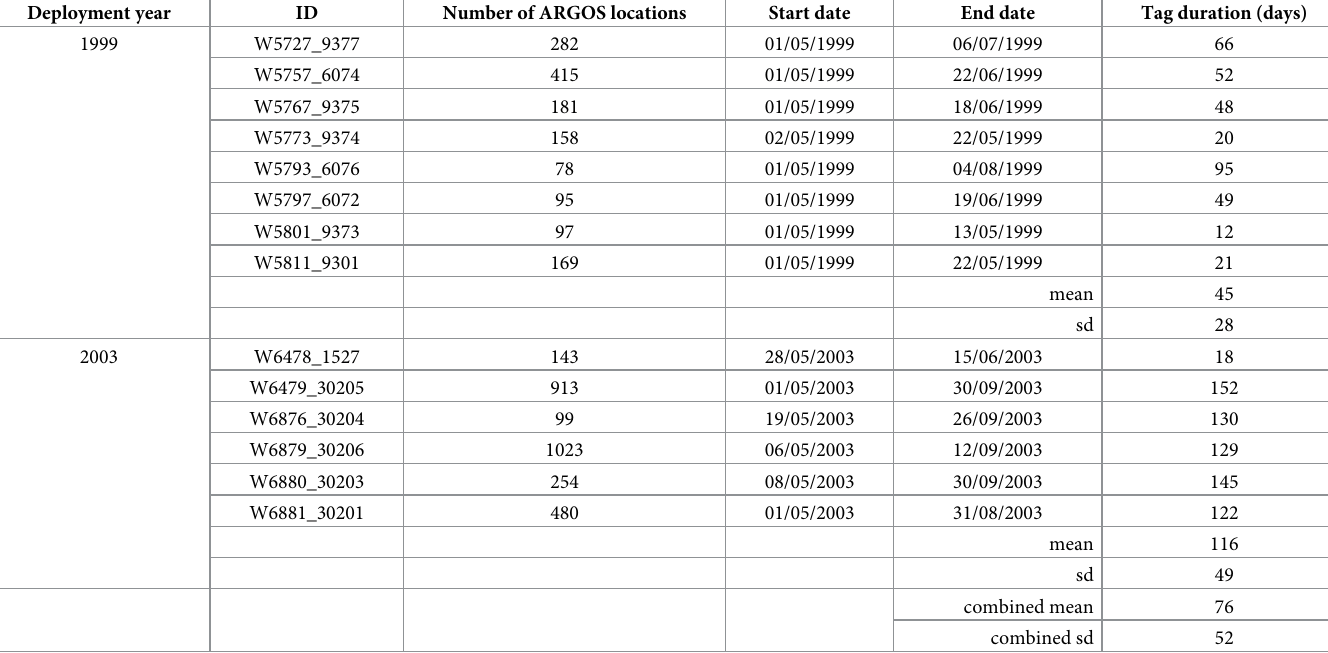
Table 1. ARGOS locations for each tagged seal, start date, end date, and durations for fur seals instrumented in 1999 (n = 8) and 2003 (n = 6). Deployment